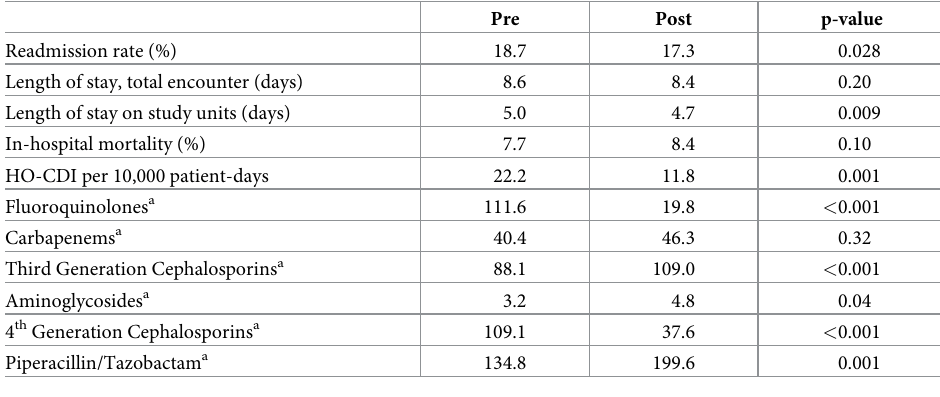
Table 2. Patient outcomes and antimicrobial